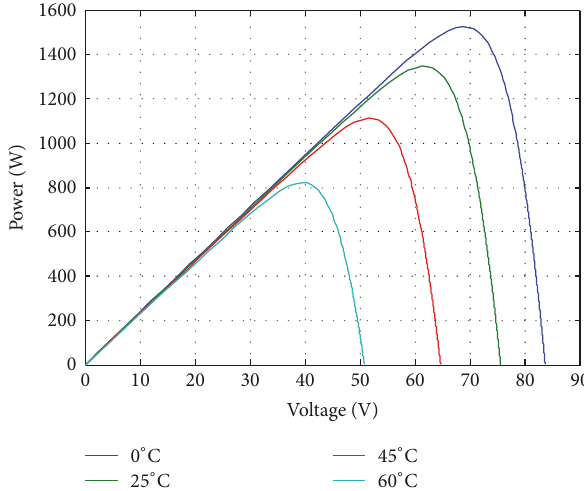
Figure 7: 𝑃 - 𝑉 curves for PV array with different ambient tempera- ture.